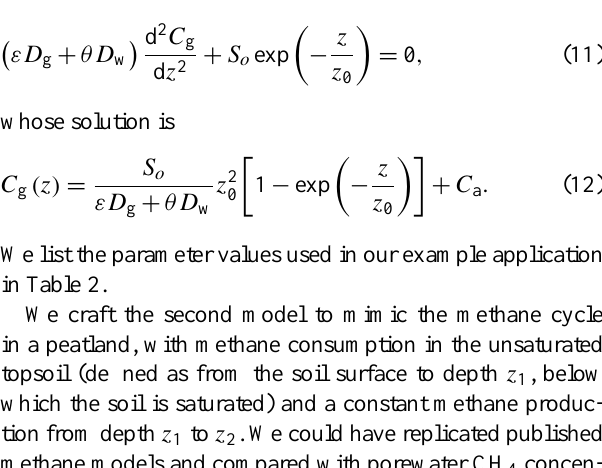
Table 2. Parameters used for the steady-state CO 2 model.